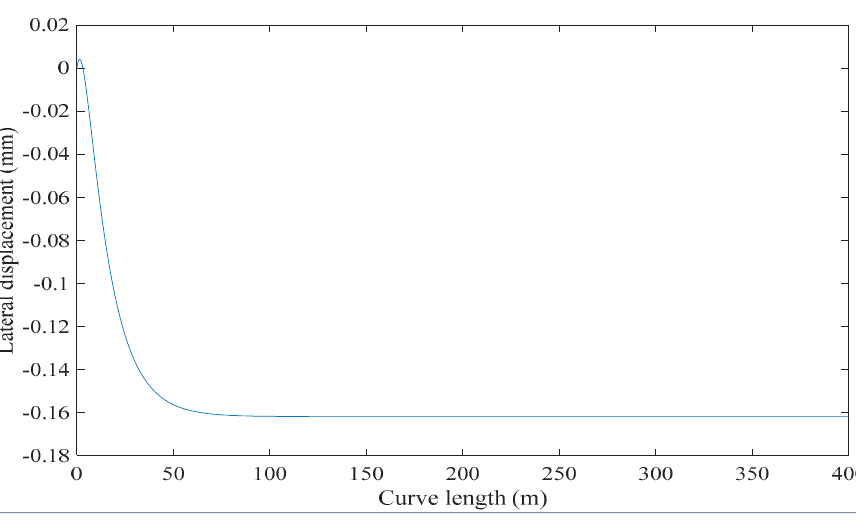
Figure 8. The lateral displacement with respect to curve length.